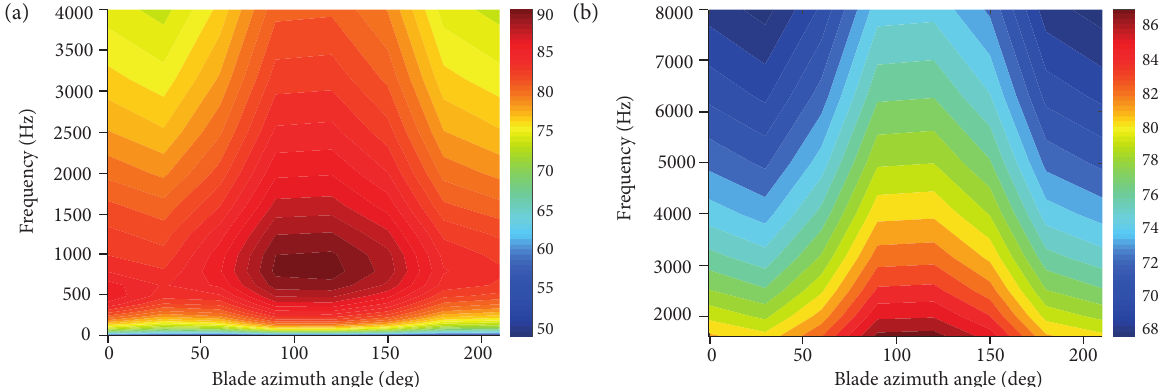
Th e noise levels for single source 1/3 rd octave band A-weighted sound spectra are shown in Figs. 3a and 3b. It is evident that at low frequency region and for blade azimuth positions, 70° to 120°, a consistent increase in sound intensity can be found. Th e maximum values in this region are ~75 dBA in the 150-200 Hz band, contributed mainly from infl ow turbulence source. As from Fig. 2b the major contribution occurs from the outboard region of blade, which increases at higher wind speeds. For any practical